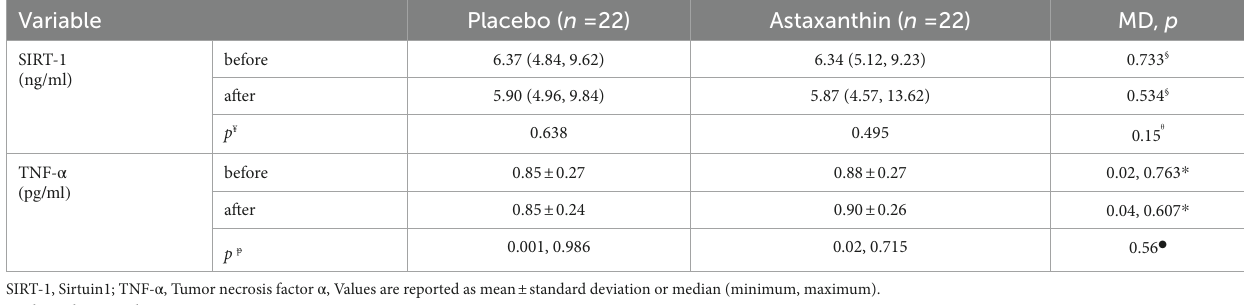
TABLE 5 Sirtuin1 and TNF- α levels.